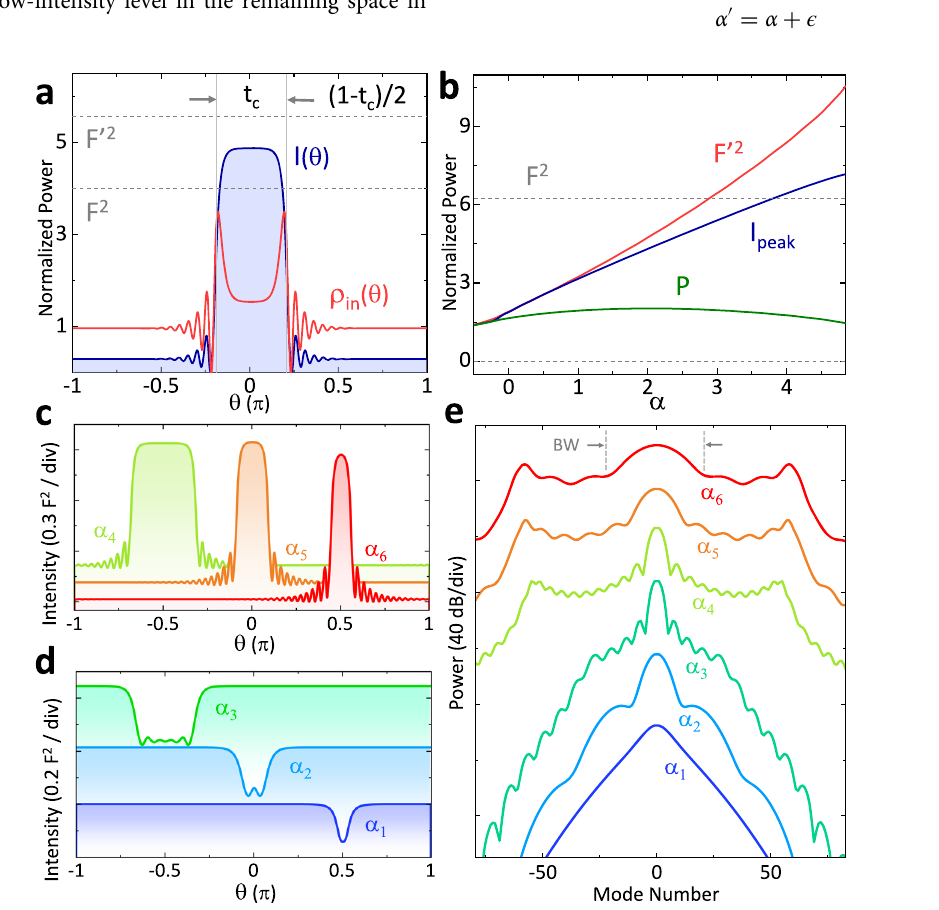
Fig. 2 Theory and simulation. a Intensity pro fi le I ( θ ) of a waveform with bright-pulse fraction t c . F 2 < I ð θ Þ < F 0 2 for the high-intensity level, where F and F 0 are the pump and effective pump parameters. The pump energy in- fl ow ρ in ( θ ) is also shown. b Calculated parameters F 0 2 , peak intensity I peak , and pump power P in the LLE. Note that I F 2 at high α . c , d Plot the waveform on the red- and blue-detuned ranges of an α sweep ( α peak > of dark-pulse duration and the decrease of bright-pulse duration with α . The corresponding spectra are shown in ( e ). Note the behavior of the center lobe bandwidth BW marked in